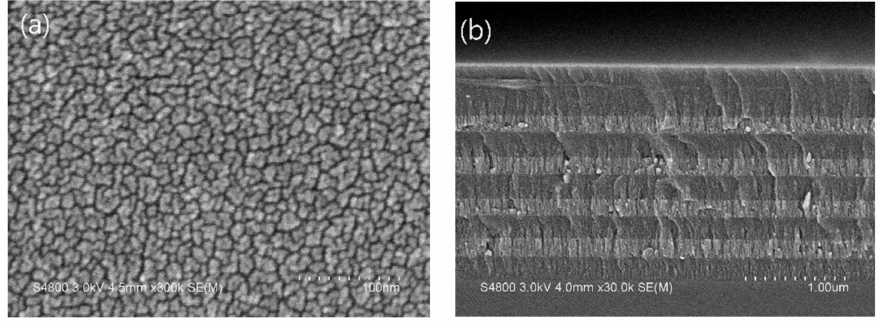
Figure 8. SEM micro-images of multilayer notch filter ( a ) top view; ( b ) cross-section.